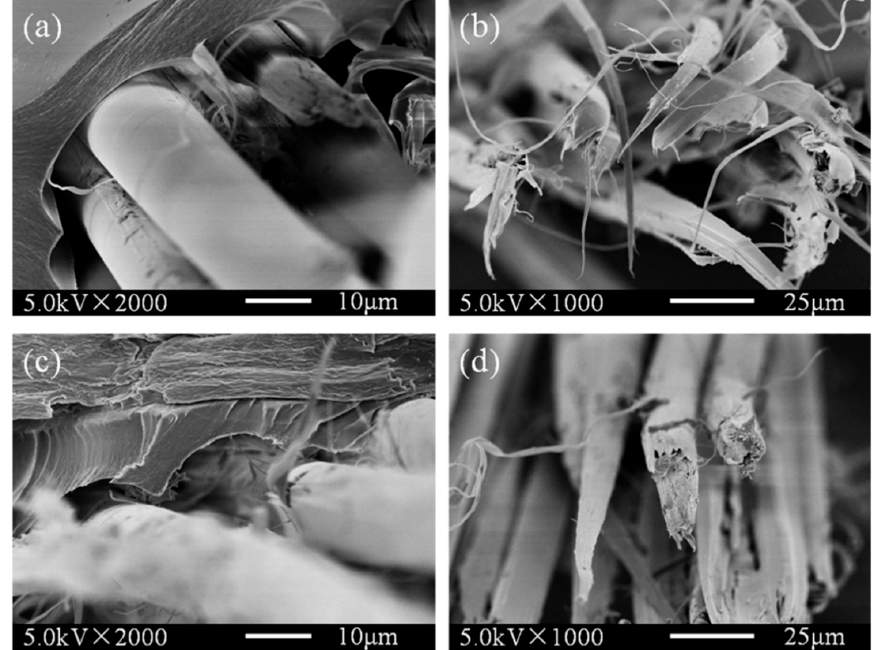
Figure 8. Tensile fracture images of the pristine ( a , b ) and plasma treated for 180 s ( c , d ) PI filaments self-reinforced composites. self-reinforced